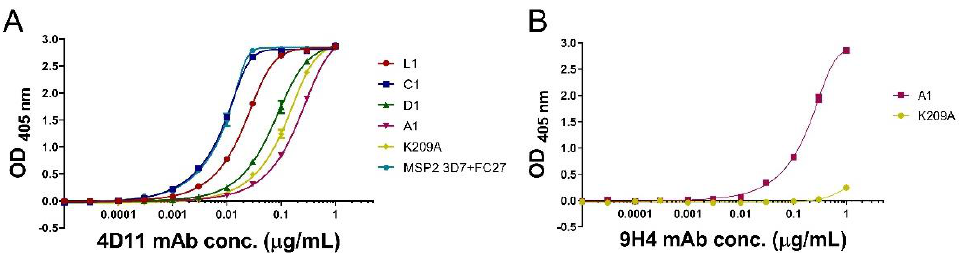
Figure 3. ( A ) Direct ELISA indicates that all peptide-KLH conjugates are recognised by mAb 4D11, ( B ) K209A-KLH is unable to bind to mAb 9H4, indicating that the 9H4 epitope had been removed successfully.